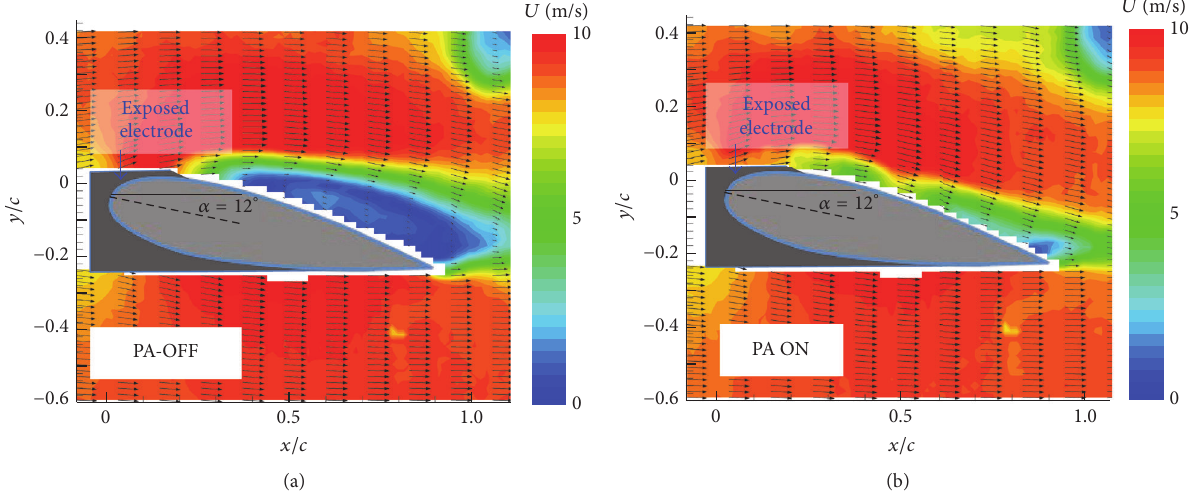
Figure6:Time-averagedvelocitydistributionsaroundtheNACA0024(50times)at 𝛼 = 12 ∘ and 𝜃 = 2 ∘ ,(a)PA-OFF;(b)PA-ONbystring-type DBD plasma actuator placed at 𝑥/𝑐 = 0.05